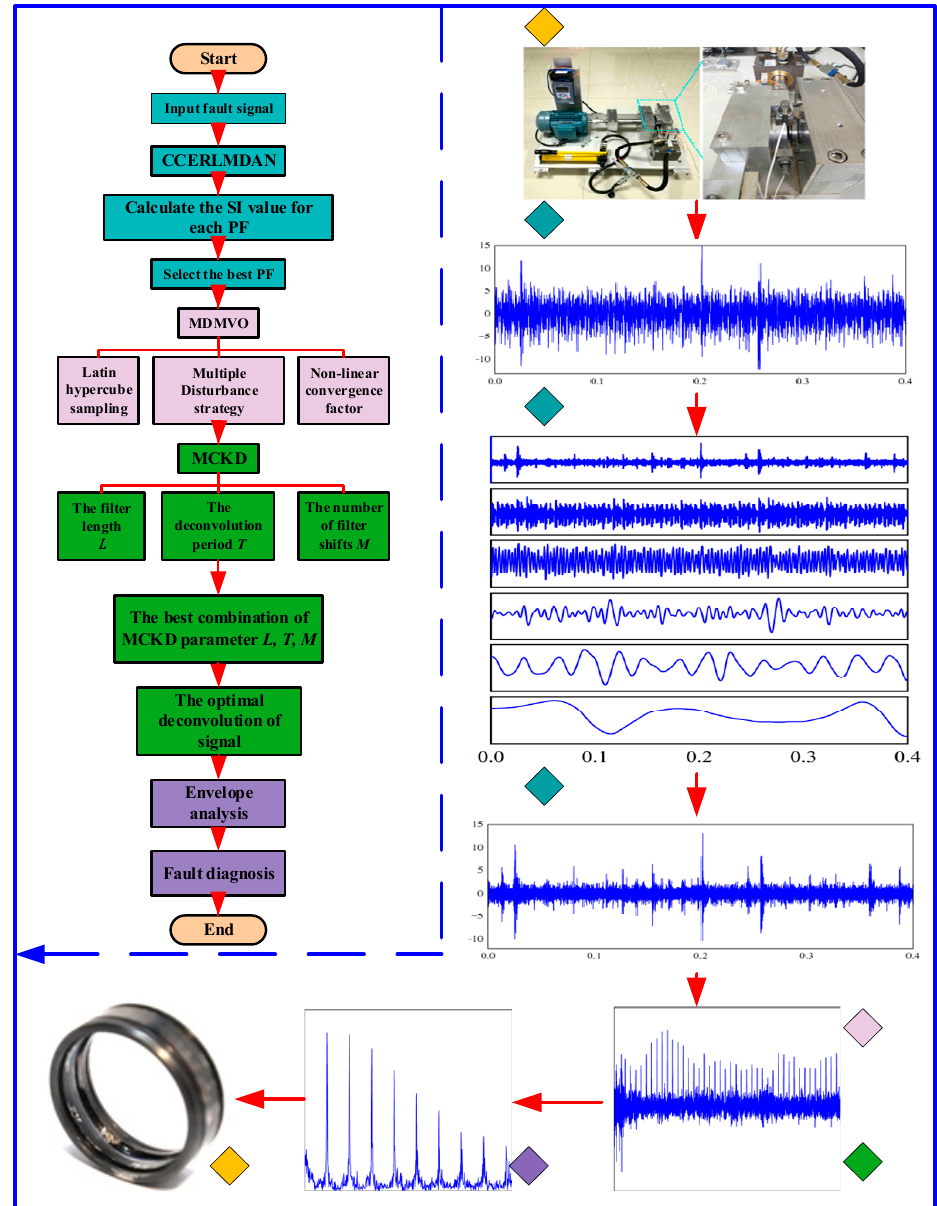
Figure 11. Flowchart for the approach of fault diagnostics proposed in this study.